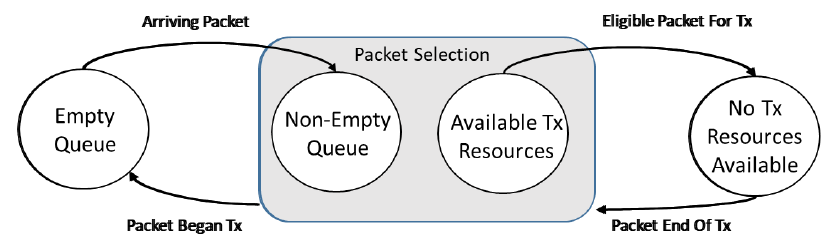
Figure 2. System state machine.